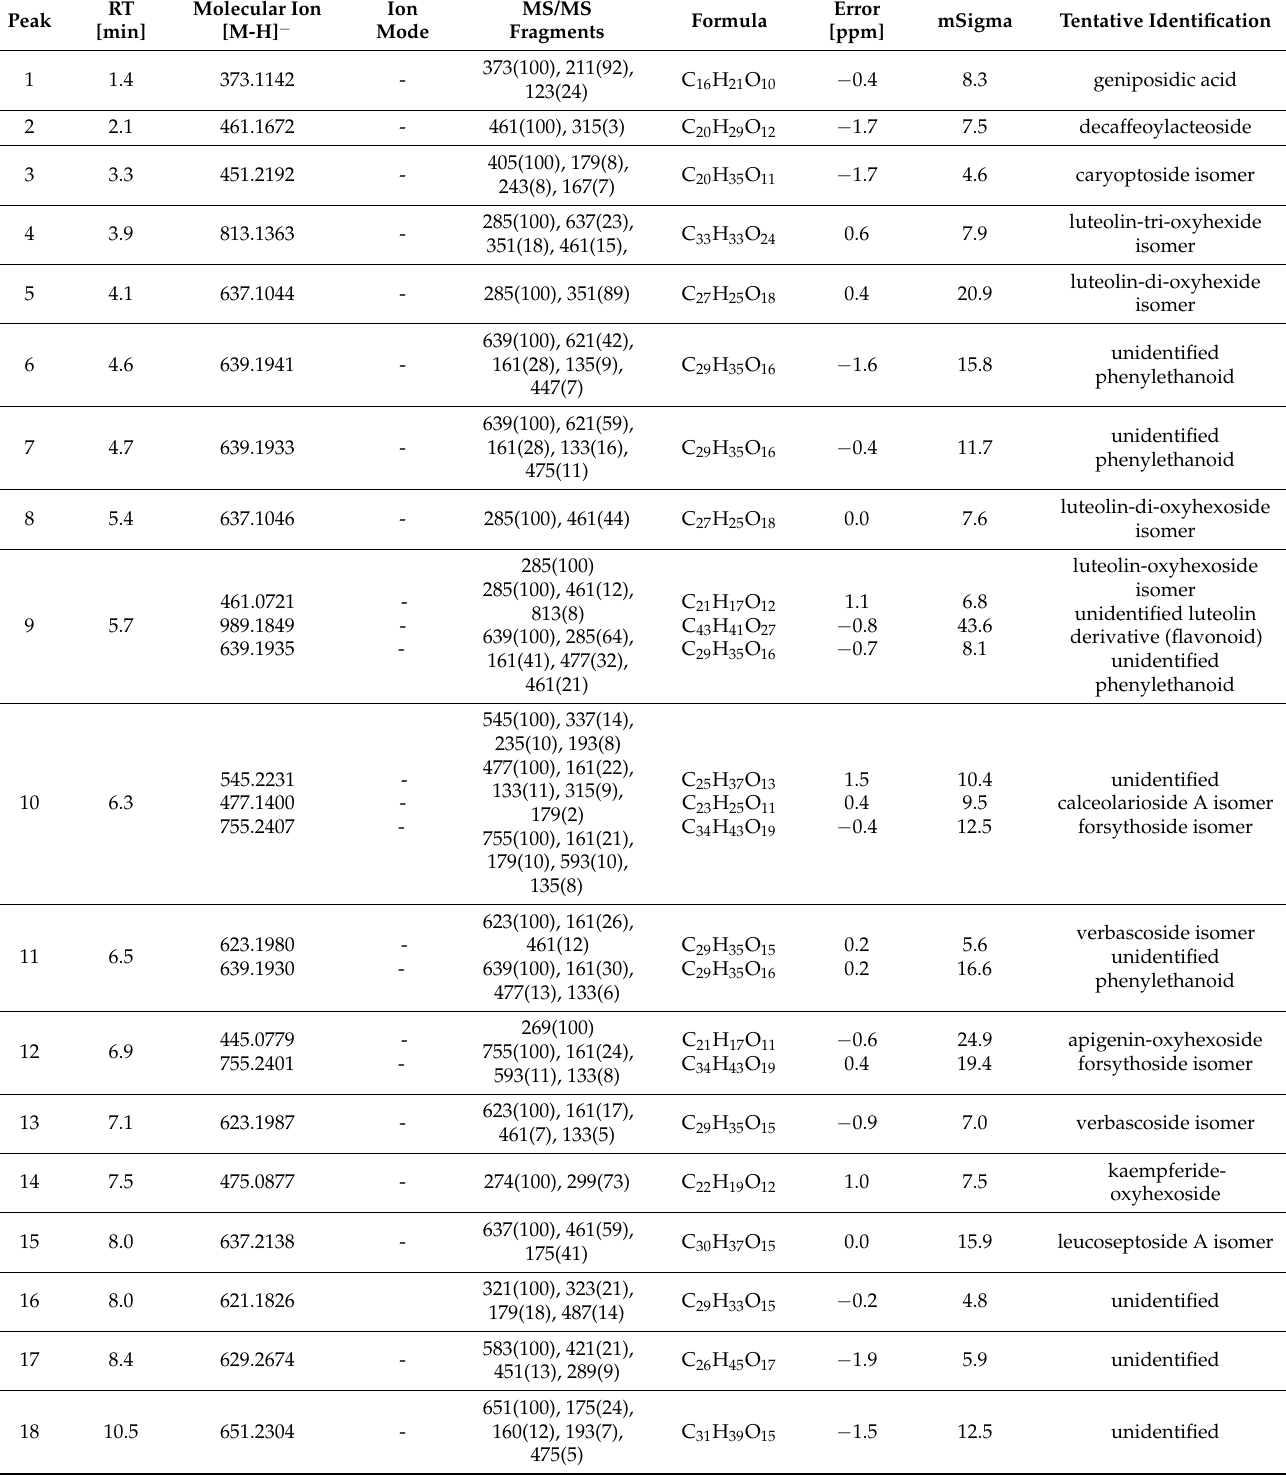
Table 8. Compounds identified in the ribwort plantain ( Plantago lanceolata L.) extract using UHPLC-QTOF-MS/MS. Compound numbers correspond to those indicated in Figure